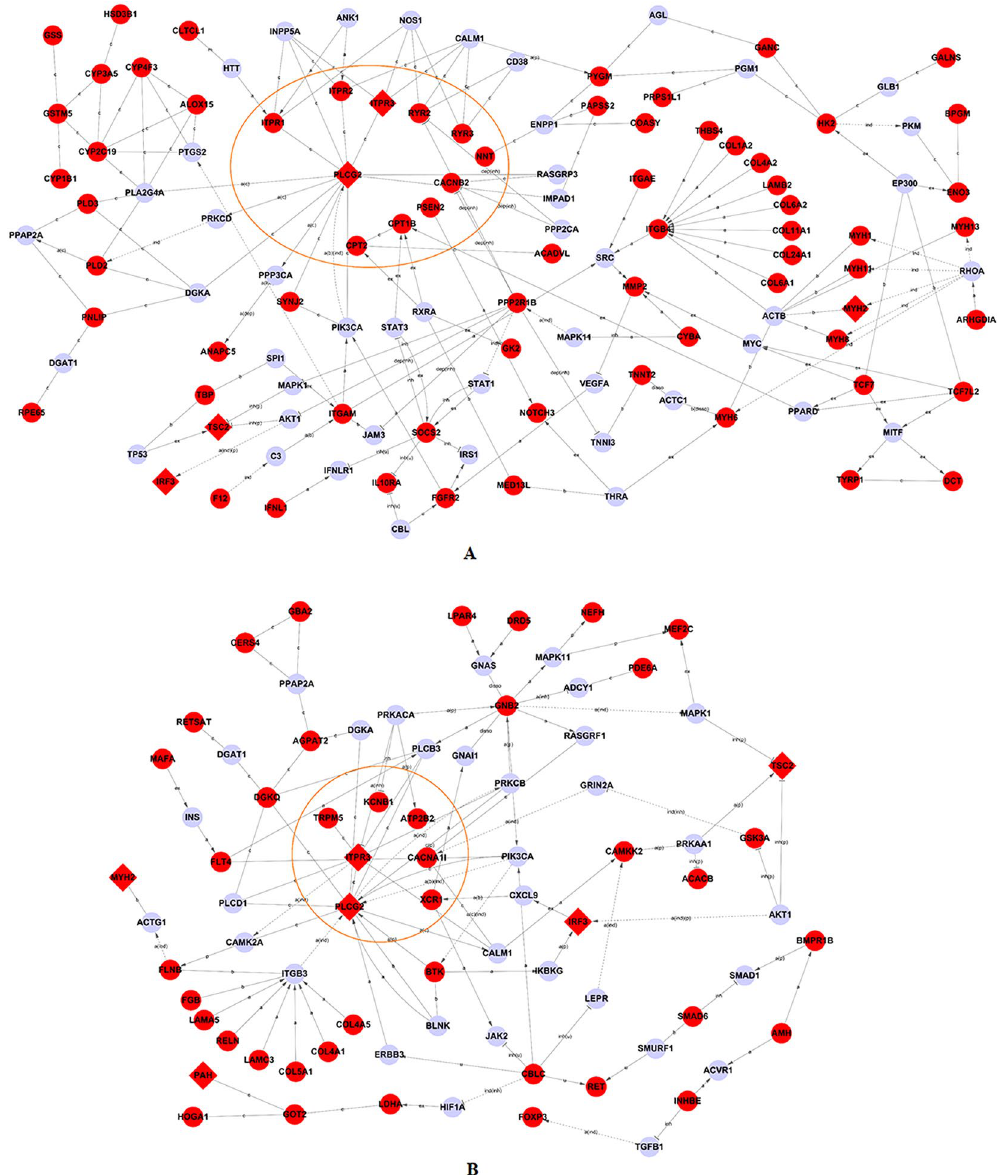
Figure 3. Functional analysis of the network containing identified rare and damaging mutations in GDs reveals enrichment for genes involved in ion transport. The network was algorithmically constructed using GeneSignalNetwork software (Genminix, Shanghai, China) based on the functional and biological connectivity of genes. The network is graphically represented as nodes (genes) and edges (the biological relationship between genes). Red nodes represent genes containing identified mutations in FtMs ( A ) and MtFs ( B ). The other nodes (light blue) are those that GeneSignalNetwork automatically includes because they are biologically linked to the studied genes based on evidence in KEGG. The genes in yellow circles participate in the process of ion